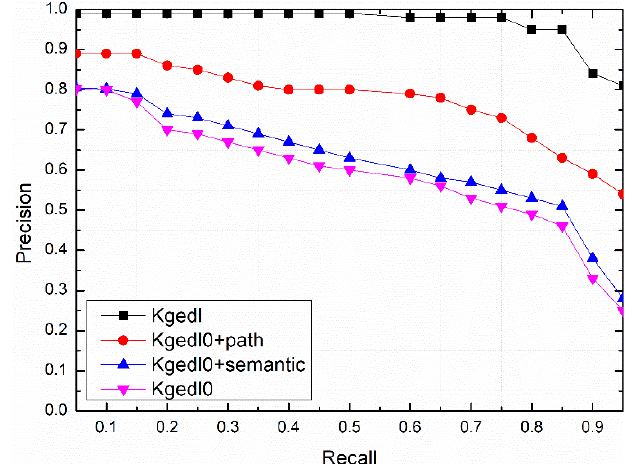
Figure 7. The comparison results of precision and recall between Kgedl and the Kgedl0, Kgedl0 + path, Kgedl0 + semantic methods on the YAGO dataset.